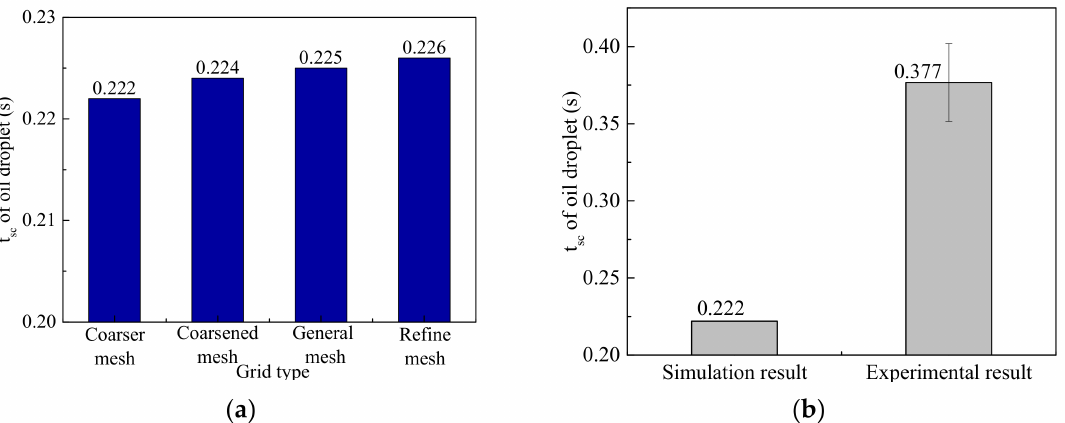
Figure 4. Grid comparison results. ( a ) Simulation results; ( b ) comparison of simulation results and experimental results.